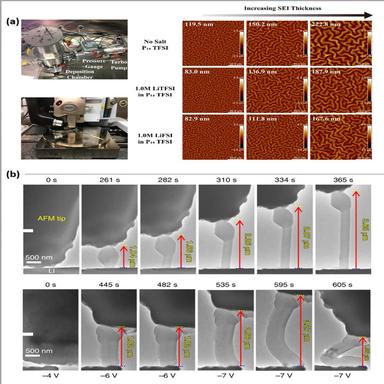
(a) Digital photos of the instruments (left side) and 2D AFM images of Li metal surface topography with P14TFSI based electrolytes (right side) (Reproduced with permission from ref. Copyright 2018 American Chemical Society); (b) in-situ AFM-ETEM studies of Li whisker growth and the evolution of mechanical behavior (Reproduced with permission from ref. Copyright 2020 Springer Nature).